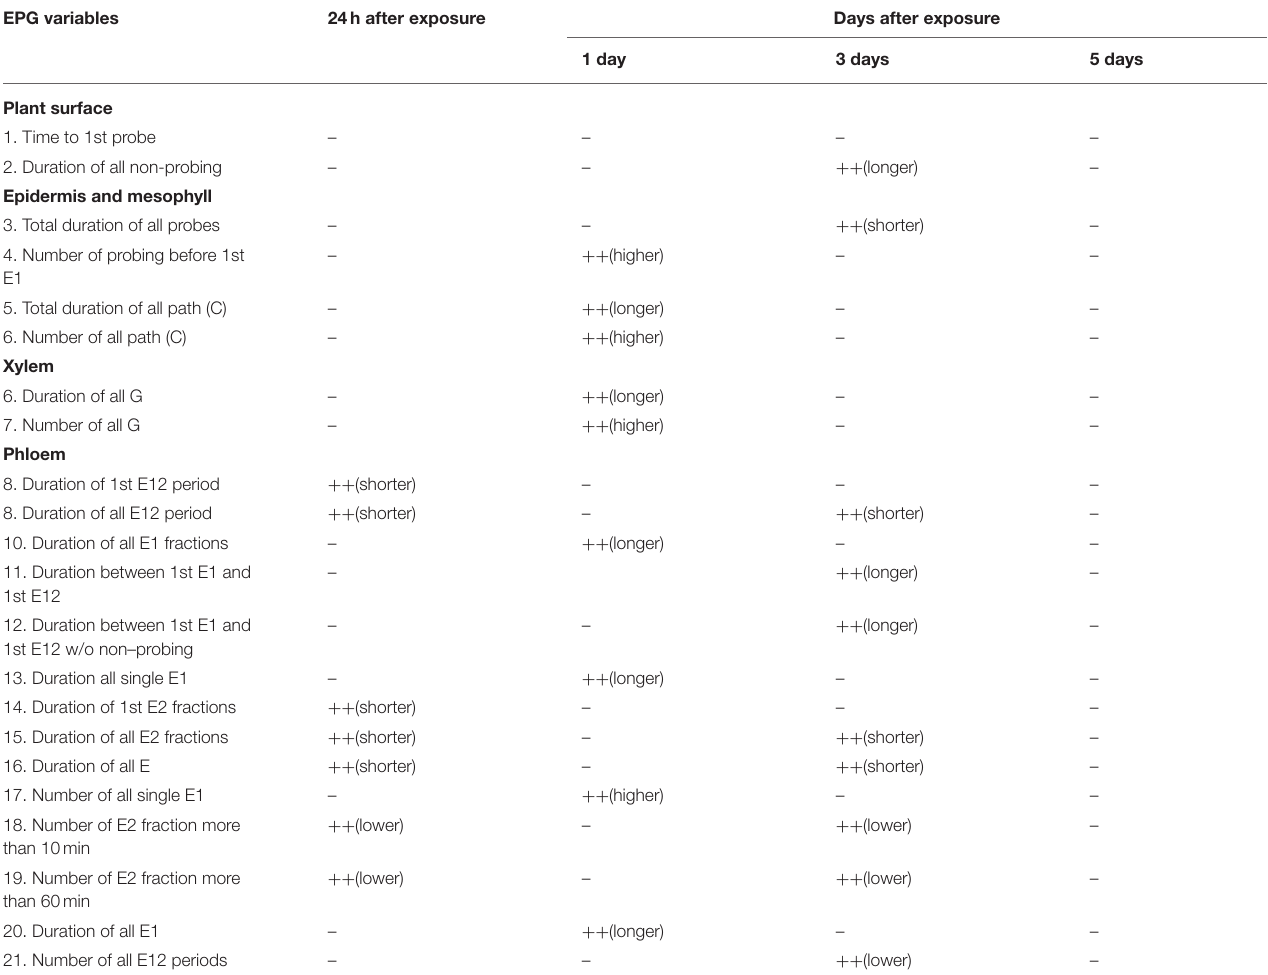
TABLE 1 | Summary of effects of exposure of barley to MeSA on feeding behaviors of R. padi on barley plants investigated using electronic penetration graph (EPG) directly after removal of MeSA exposure and at time points 1 and 3 days after removal. EPG